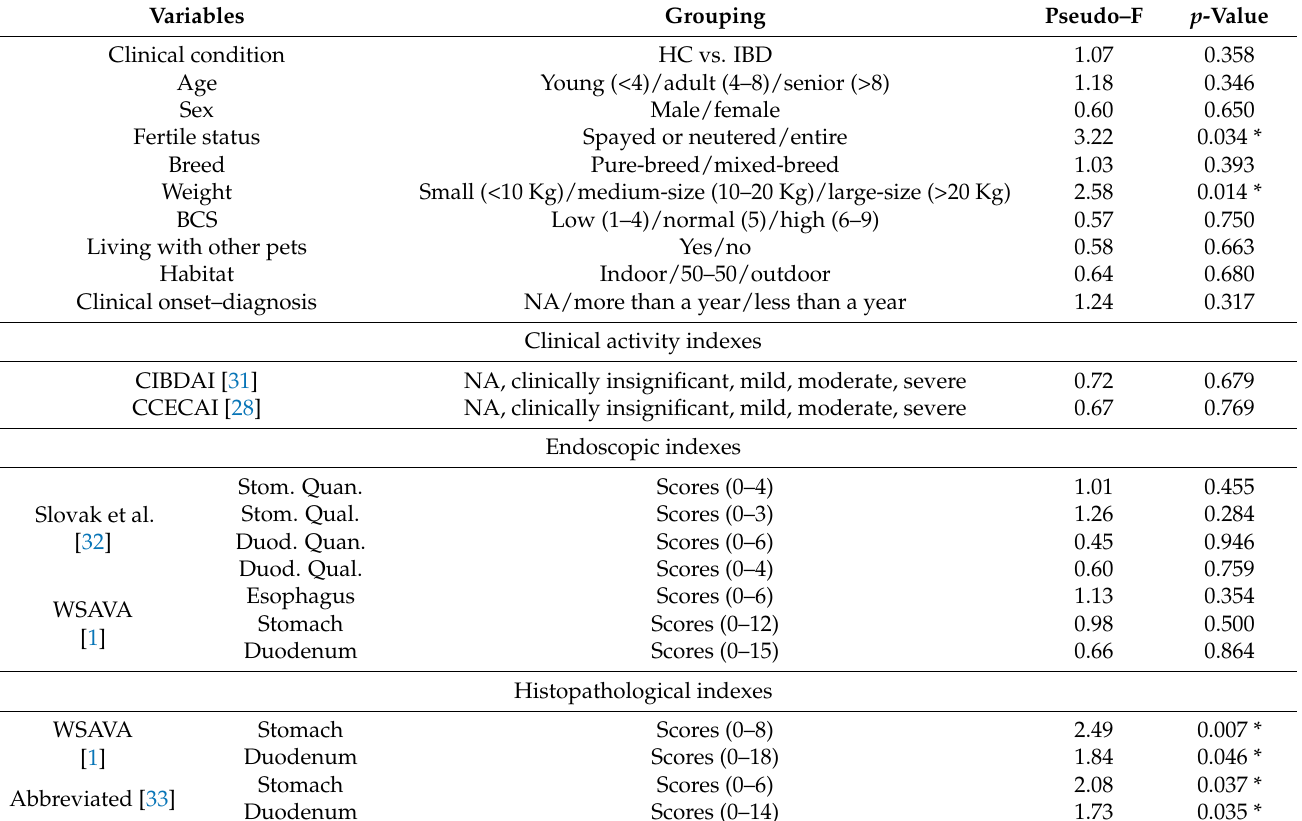
Table 4. Permutational multivariate analysis of variance (PERMANOVA) in bacterial compositions of duodenal biopsy specimens considering different